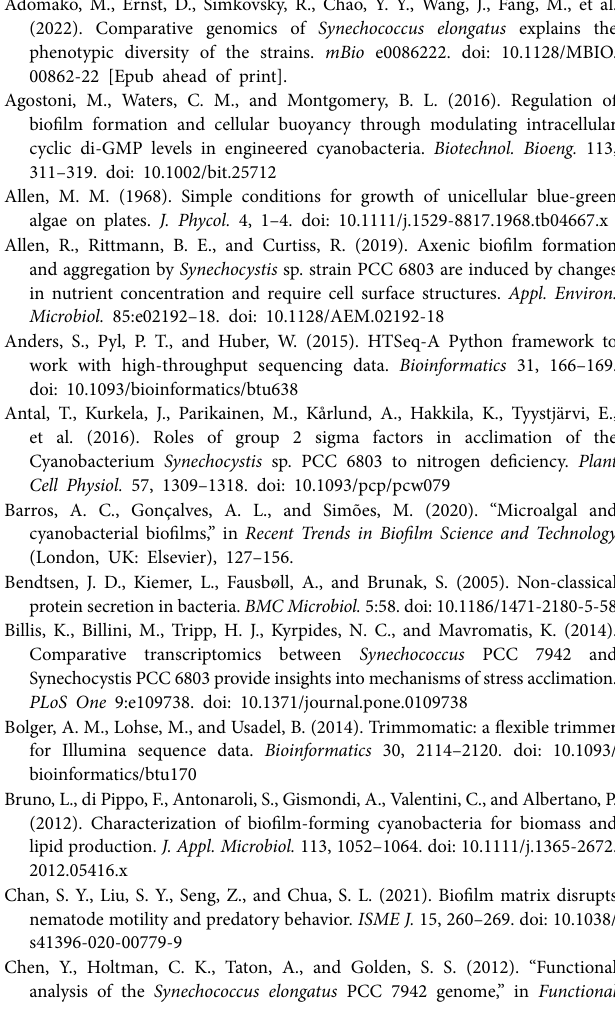
Figure 1D , (15) the reduced set of DEGs for Day 1 comparison data, (16) the reduced set of sDEGs for Day 1 comparison data used to produce the right graph of Figure 1D , (17) enrichment analysis data for named DEG clusters of interest for all gene categories listed in Supplementary Table S3 , and (18) enrichment analysis data for named sDEG clusters of interest for all gene categories listed in Supplementary Table S3 .